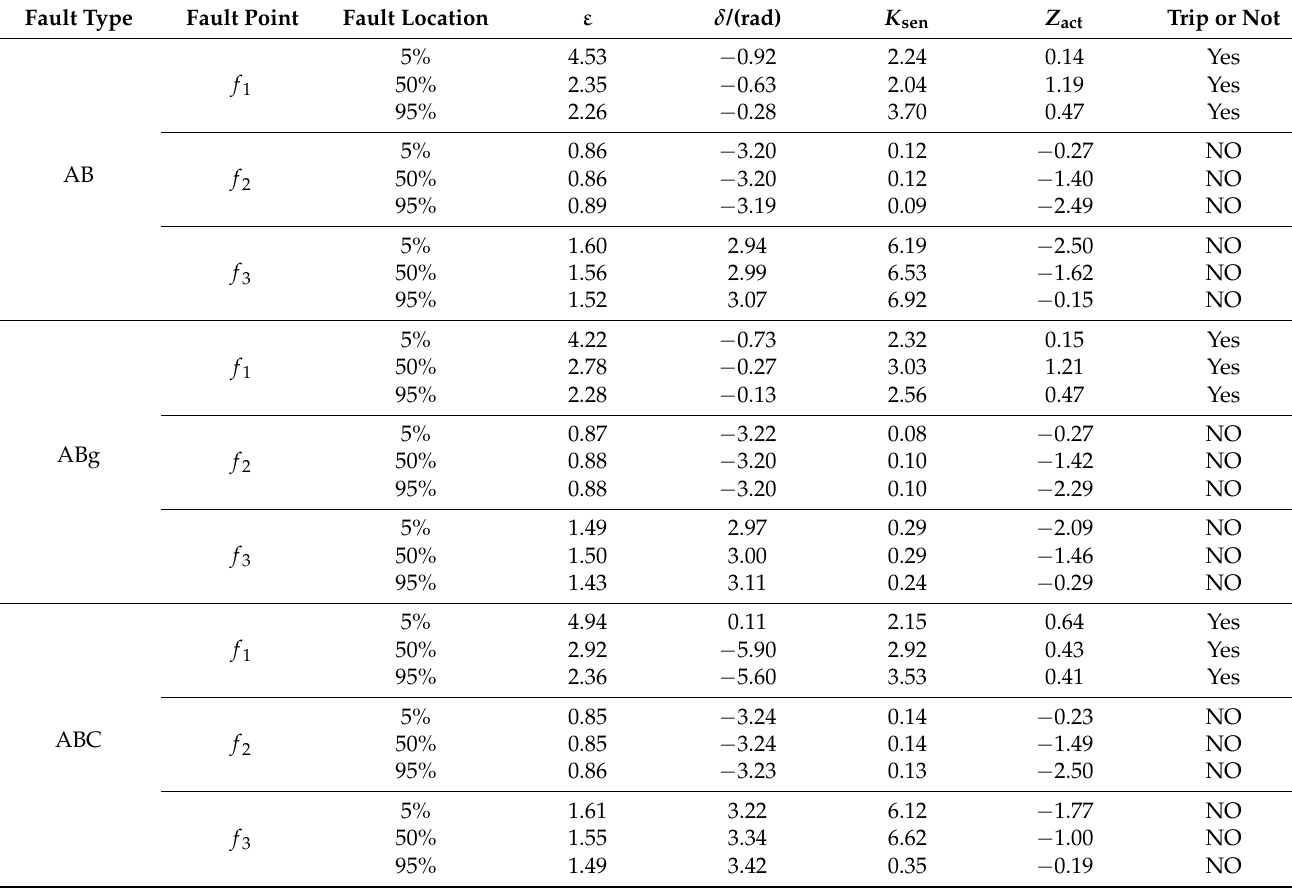
Table 6. Simulation results of the unmeasured load branch